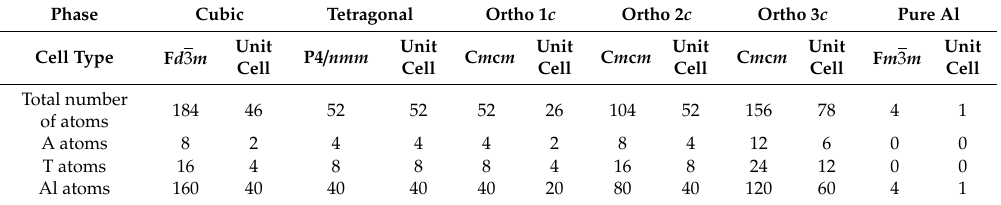
Table 2. Total number of each type of atoms in the conventional lattice cell (denoted by the space group notation) and in the corresponding unit cell used for the density functional theory (DFT) calculations. Orthorhombic structure is referred by